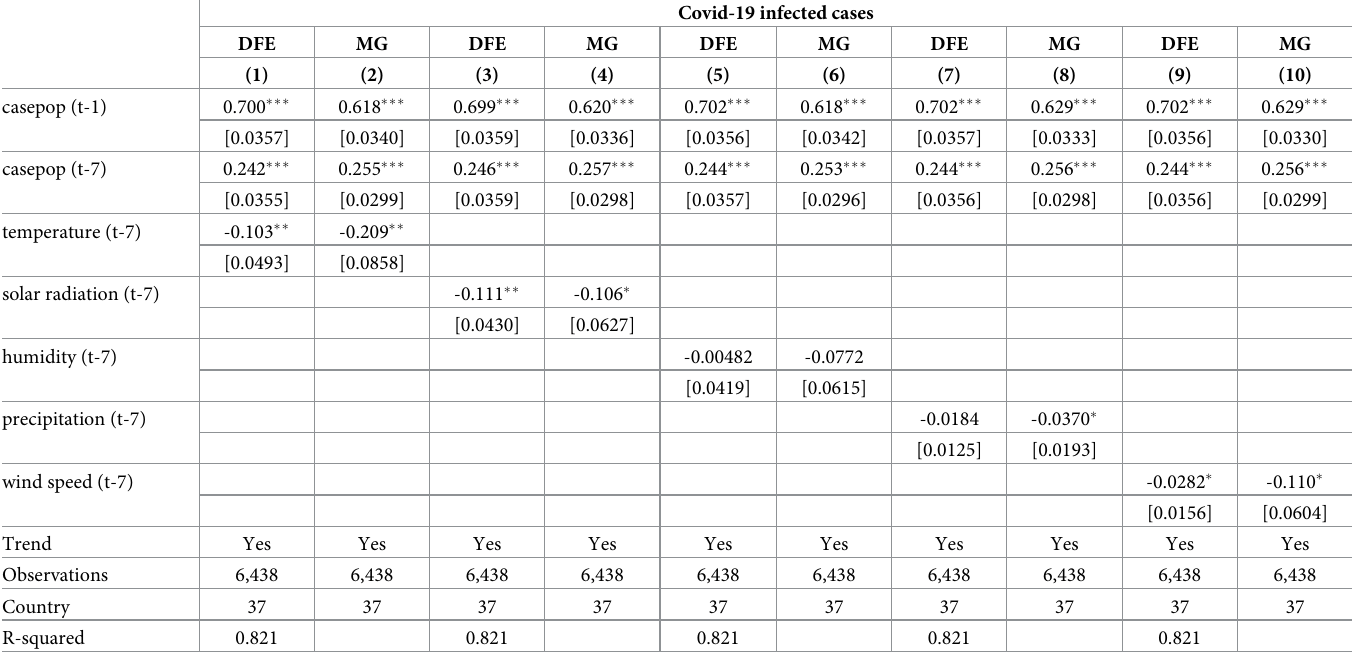
Table 4. Direct effects of climate variables on Covid-19 infected